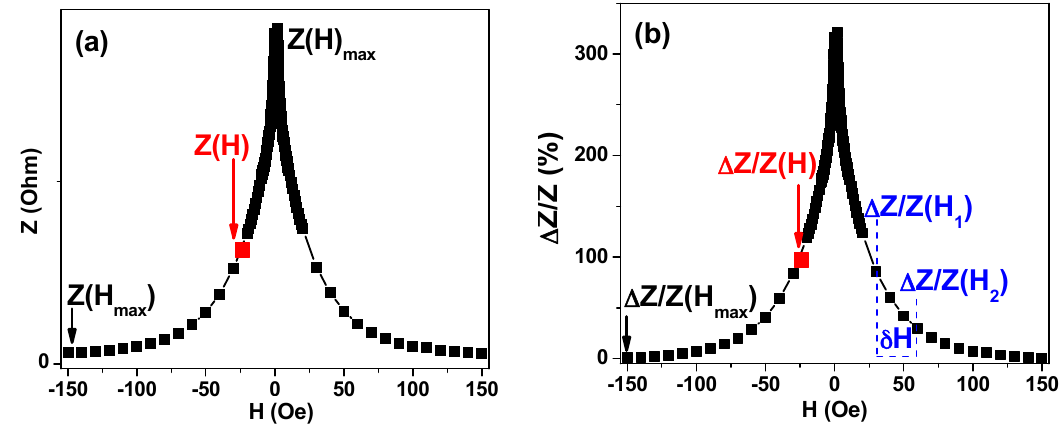
Figure 11. Magnetoimpedance related definitions for magnetoimpedance ratio ∆ ( Z/Z )(H) ( a ) and MI ratio sensitivity S( ∆ ( Z/Z )(H) calculations ( b ).